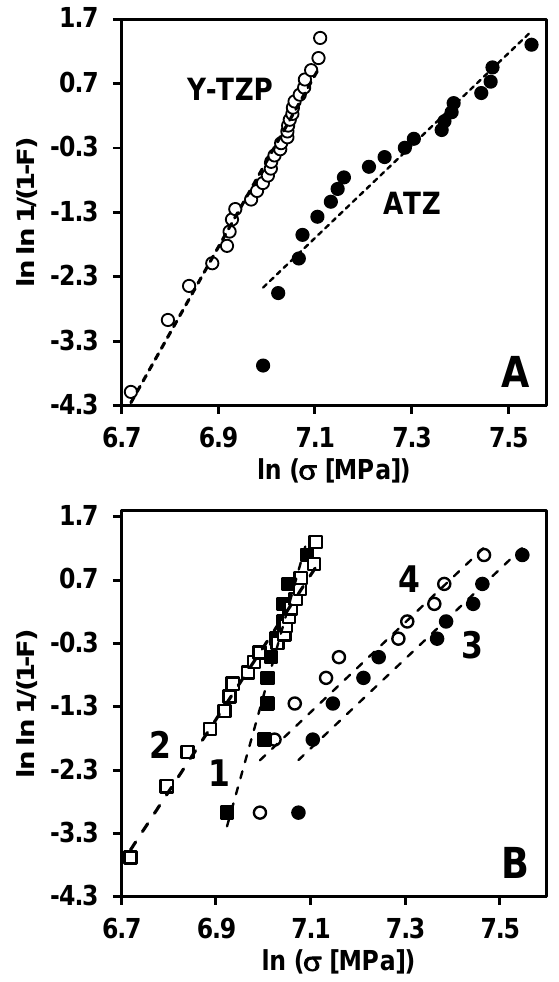
Figure 3. Weibull distribution of four-point bending strength of Y-TZP and ATZ ceramics. ( A ) Weibull plots, where all 30 samples of Y-TZP and 20 samples of ATZ ceramics were counted, ( B ) Weibull plots, where strength data of 10 samples of Y-TZP machined by a process #1 and 20 samples of Y-TZP machined by a process #2, along with strength data of 10 samples of ATZ machined by a process #1 and 10 samples of ATZ machined by a process #2 are shown separately for each compo- sition with different machining.